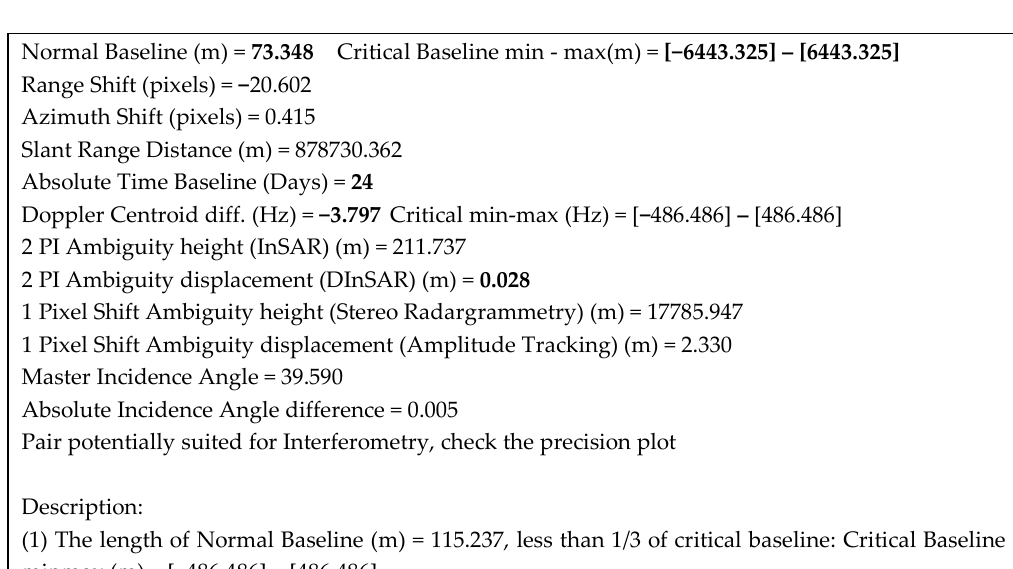
Figure 6. Baseline estimate result.